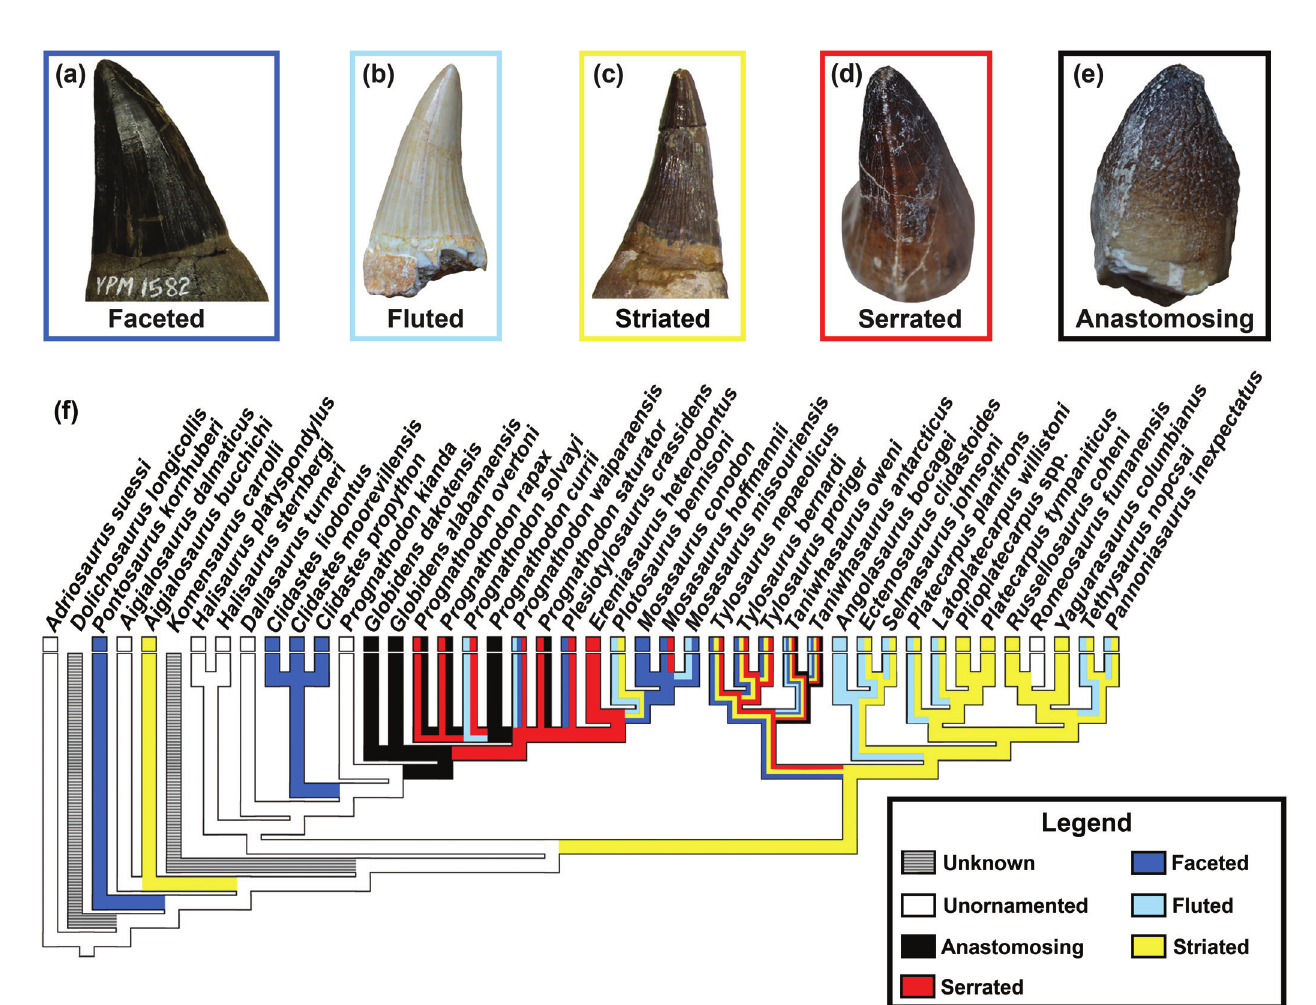
Figure 1. Mosasaur tooth crown characters examined in this study. A, faceted tooth; B, fluted tooth; C, lingually striated tooth; D, tooth with serrated carina; E, tooth with coarse anastomosing texture; F, phylogeny derived from Simões et al. (2017) with the distribution of these characters, as scored in previous analyses, mapped across the